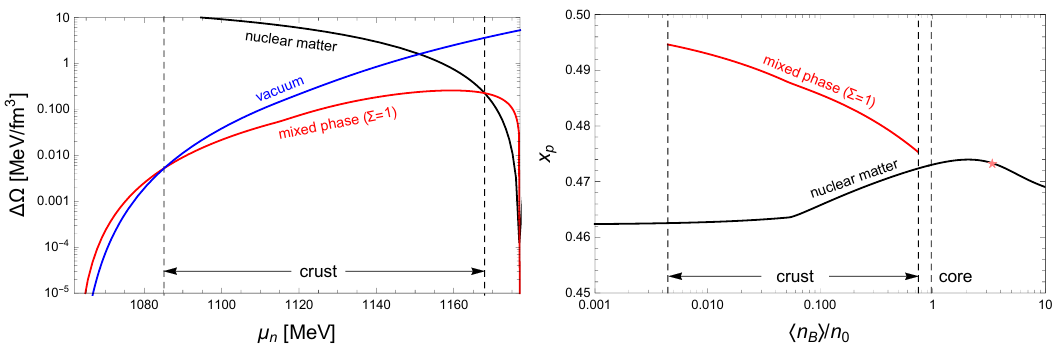
Figure 1: Left panel: Free energy densities relative to the mixed phase without Coulomb and surface effects as a function of the neutron chemical potential. The surface tension is set to Σ = 1MeV / fm 2 . Right panel: Corresponding proton fraction as a function of the spatially averaged baryon density, normalized by the saturation density of nuclear matter. The star indicates the density and proton fraction in the = 949MeV, resulting center of the most massive star. For both panels, λ = 10, M KK (cid:39) 0.21fm − 3 , somewhat larger than in in a saturation density n 0